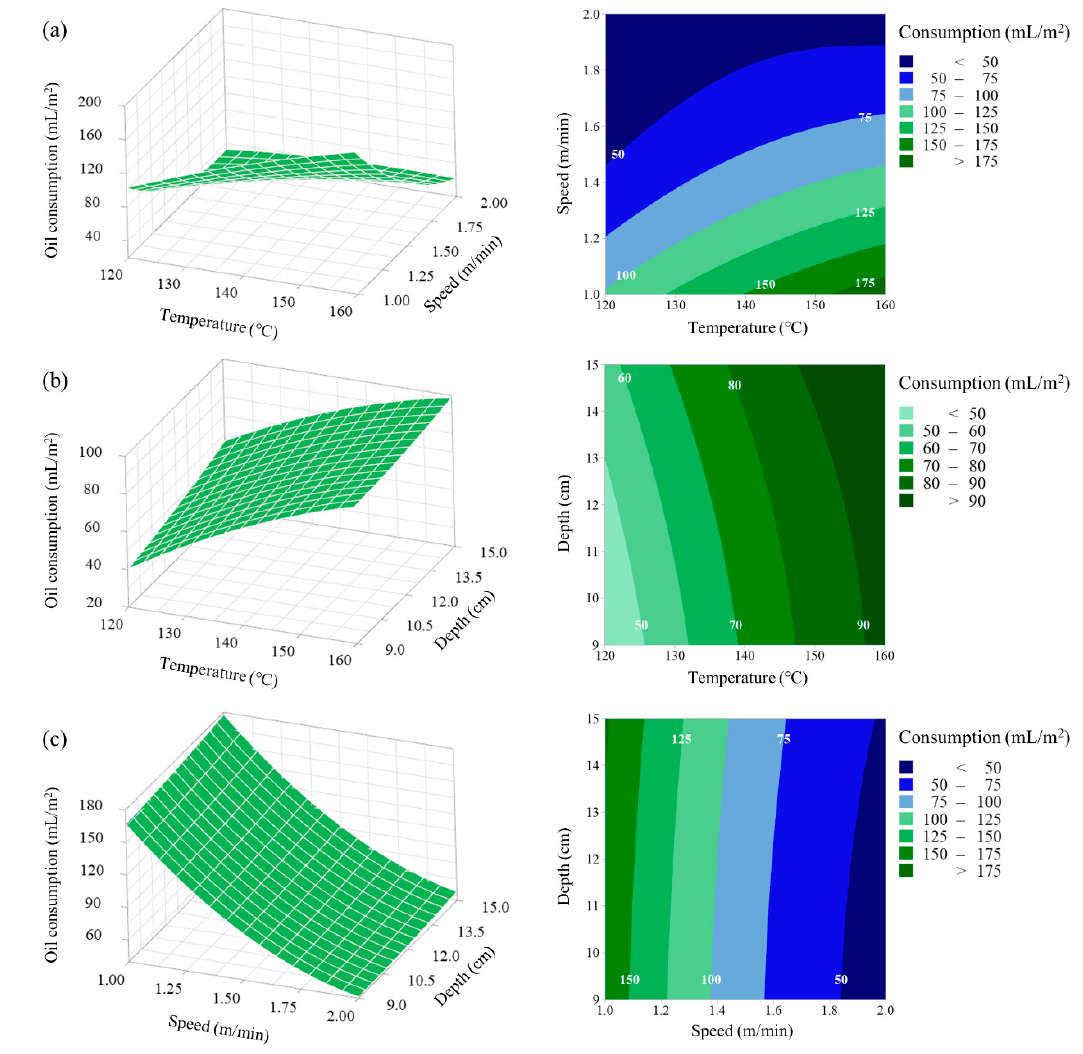
Figure 4. Response surface plots presenting the interaction effects of three variables on oil consumption: ( a ) surface plot showing the effect of the steam temperature and running speed on oil consumption, ( b ) surface plot showing the effect of the steam temperature and spray depth on oil consumption, and ( c ) surface plot showing the effect of the running speed and spray depth on oil consumption.